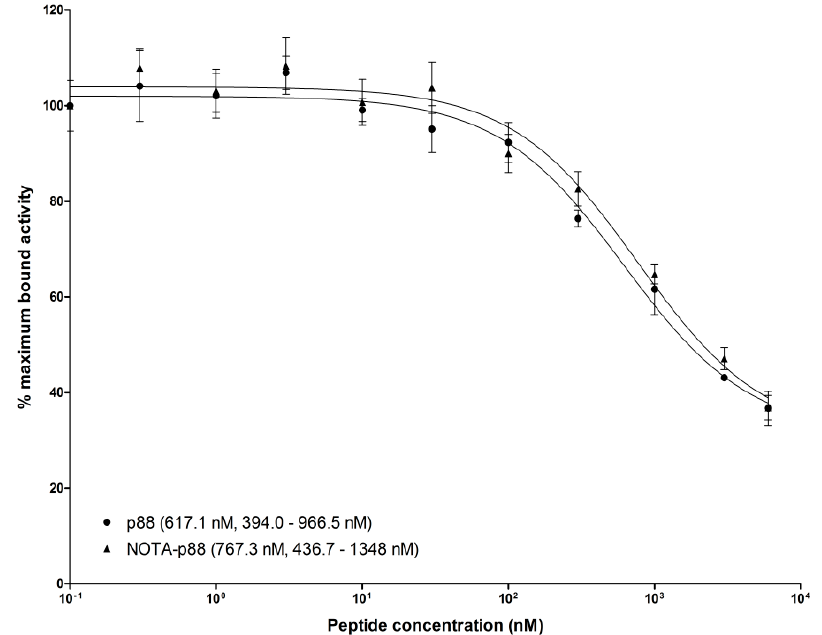
Figure 7. Competitive binding assay. CHO-FXYD2 cells were seeded in six-well plates at a density of 10 6 cells/well 24 h prior to the experiments. Serial dilutions of unlabeled NOTA-P88 and P88, at a final concentration ranging from 0.1 to 6000 nM ( n = 3), were added along with 1000 Bq [ 111 In]In-NOTA-P88. After 4 h incubation at 37 °C, the cells were washed, and the cell-associated radioactivity was determined in a well-type γ -counter. The IC 50 values were calculated by one-site competition analysis.